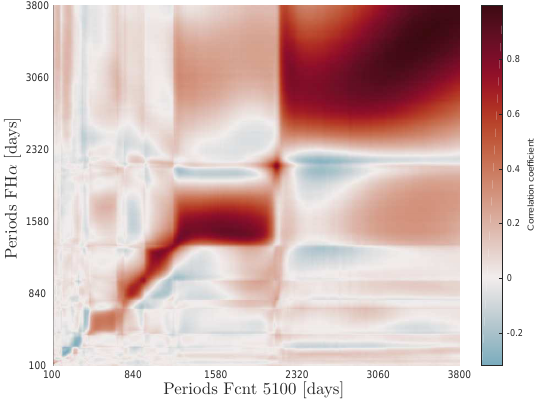
Figure 4. A 2D correlation map of continuum and H α emission line of NGC 3516, with matching period of 1580 ± 743 days. Upper right peak corresponds to whole period covered by